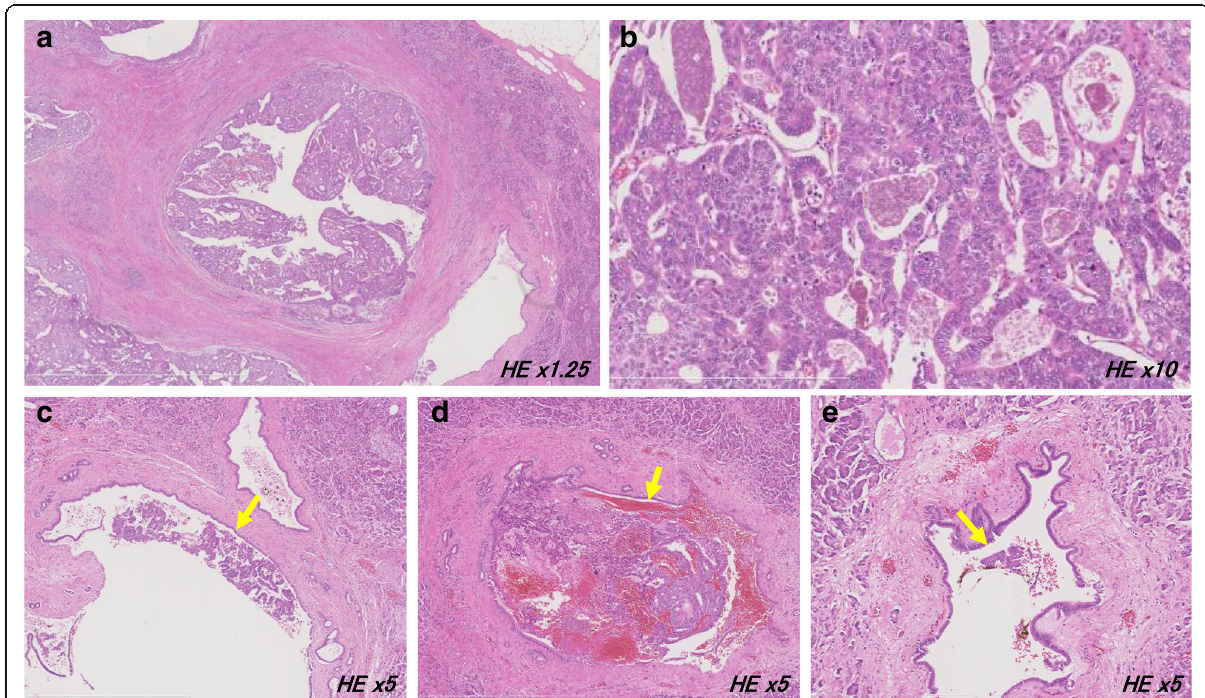
Fig. 5 Histopathological findings of the resected specimens in the second surgery. a , b The main tumor infiltrated into the main duct and the surrounding branch of the pancreatic duct. c – e Each tumor mass floated in the main pancreatic duct (arrow). No obvious malignant finding was observed in the pancreatic duct epithelium at each